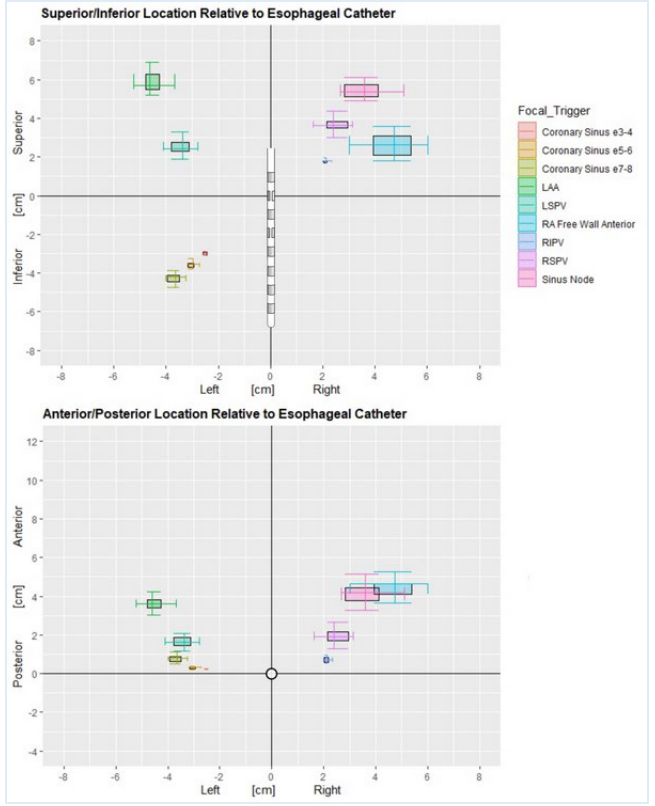
Fig 2: Localization of stimulated focal trigger sites in the atria from one patient of our patients, (Left/right versus Superior/inferior in top panel; Left/right versus anterior/posterior in bottom panel). Due to signal qual- ity, not all 18 stimulated focal trigger sites are